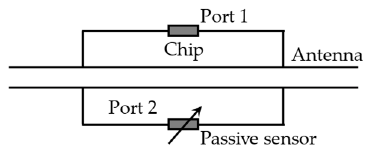
Figure 10. Two-port sensor tag.